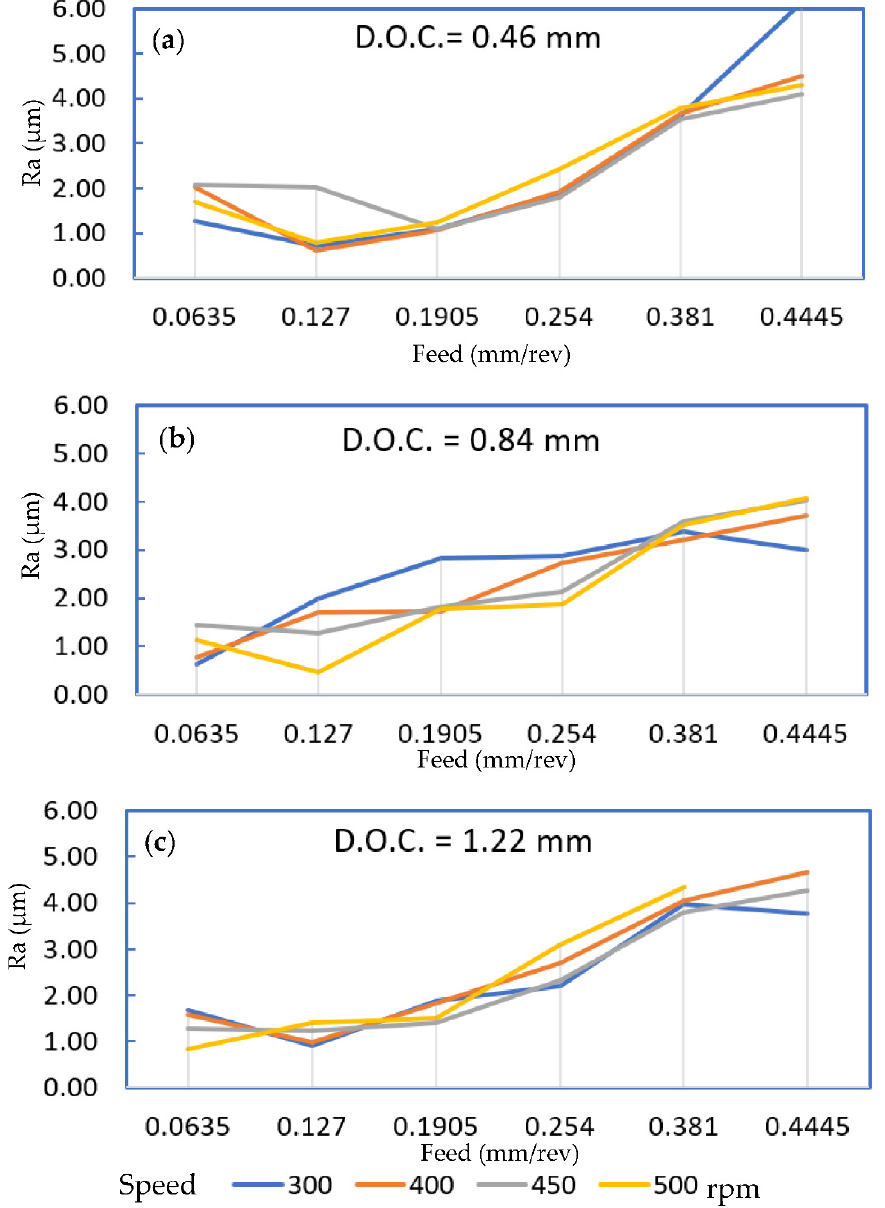
Figure 2. Averaged surface roughness (Ra) in µm at four speeds for ( a ) D.O.C. = 0.46 mm, ( b ) D.O.C. = 0.84 mm, and ( c ) D.O.C. = 1.22 mm.